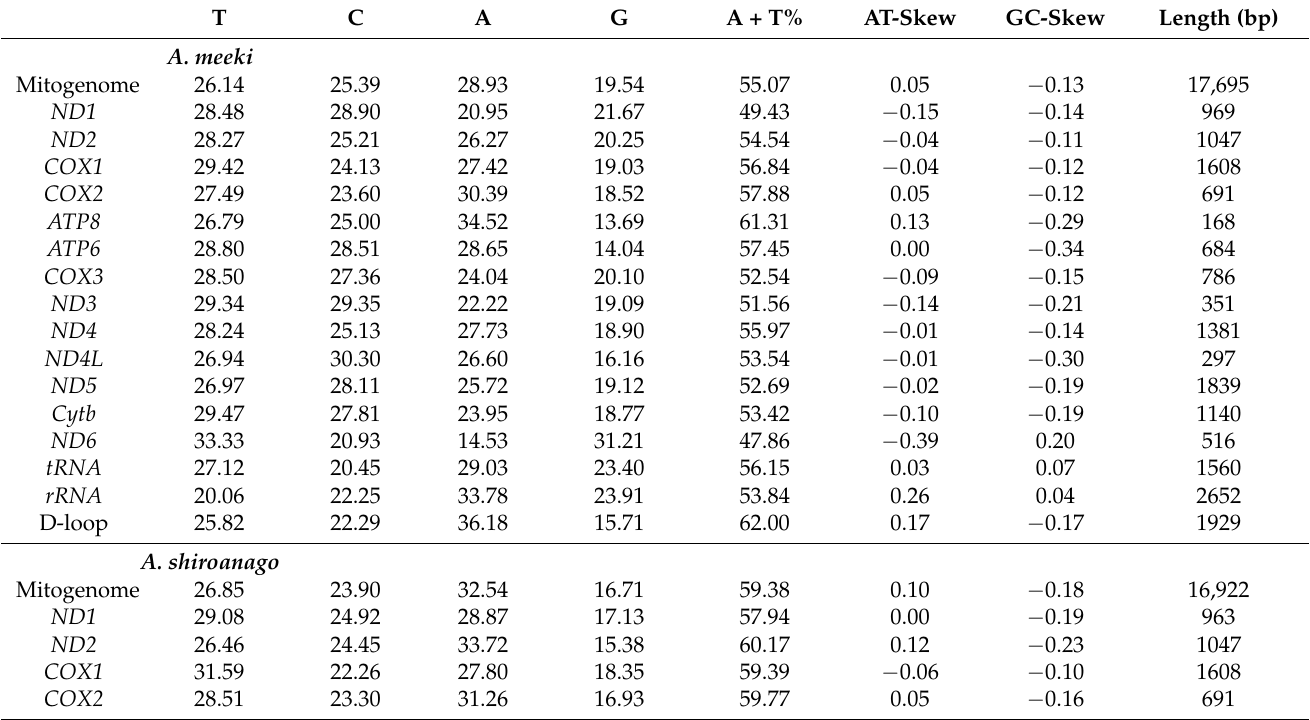
Table 3. Composition and skewness of the A. meeki and A. shiroanago